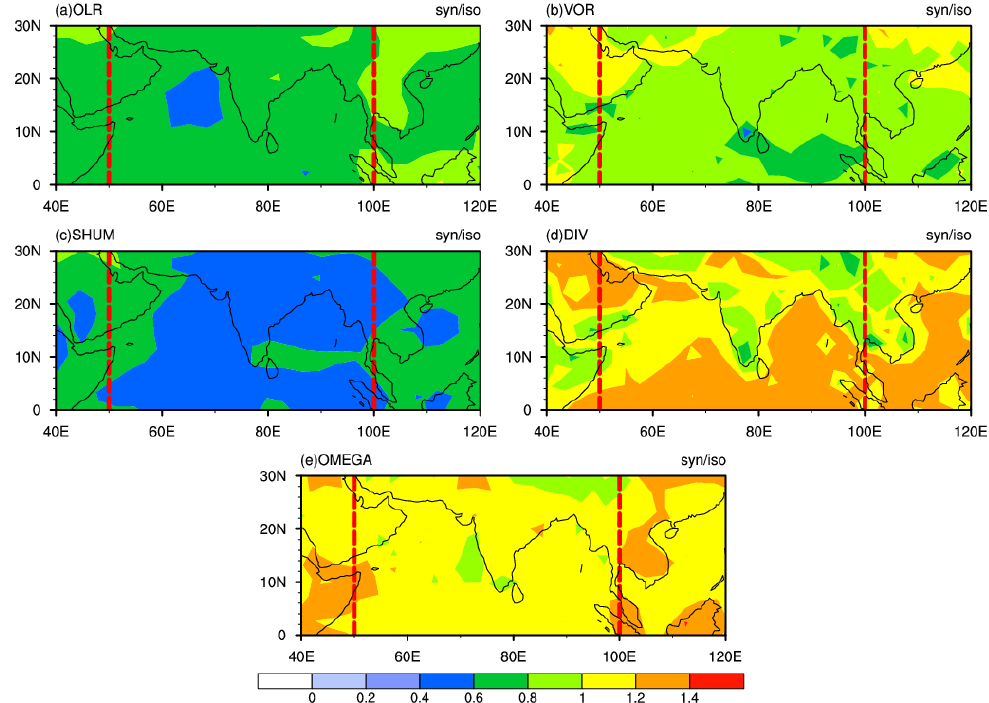
Figure 8. The ratios of the standard deviations in ( a ) OLR, ( b ) 850 hPa relative vorticity, ( c ) 700 hPa specific humidity, ( d ) 850 hPa divergence, and ( e ) 500 hPa vertical p-velocity between the synoptic and intraseasonal components over the NIO during AMJJASOND of the period 1979–2020. The red dashed lines indicate the main region of the NIO.